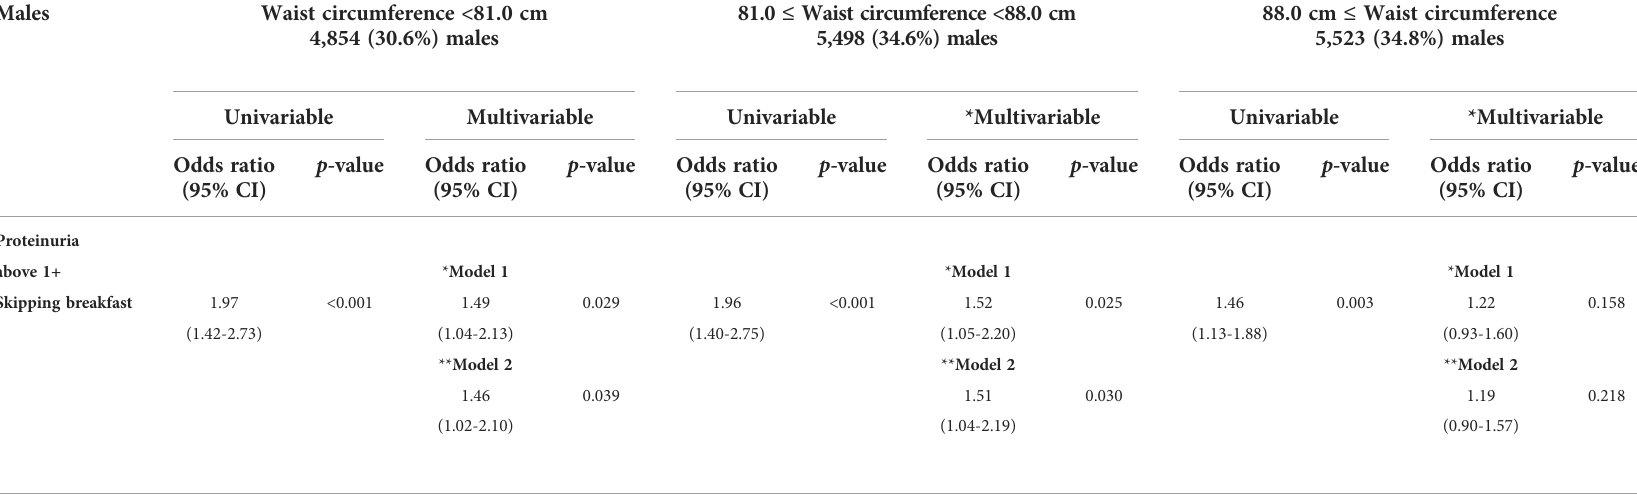
TABLE 4A Logistic regression analysis for analysis for the skipping breakfast and the prevalence of proteinuria above 1+ in 15,875 males strati fi ed by waist circumference.